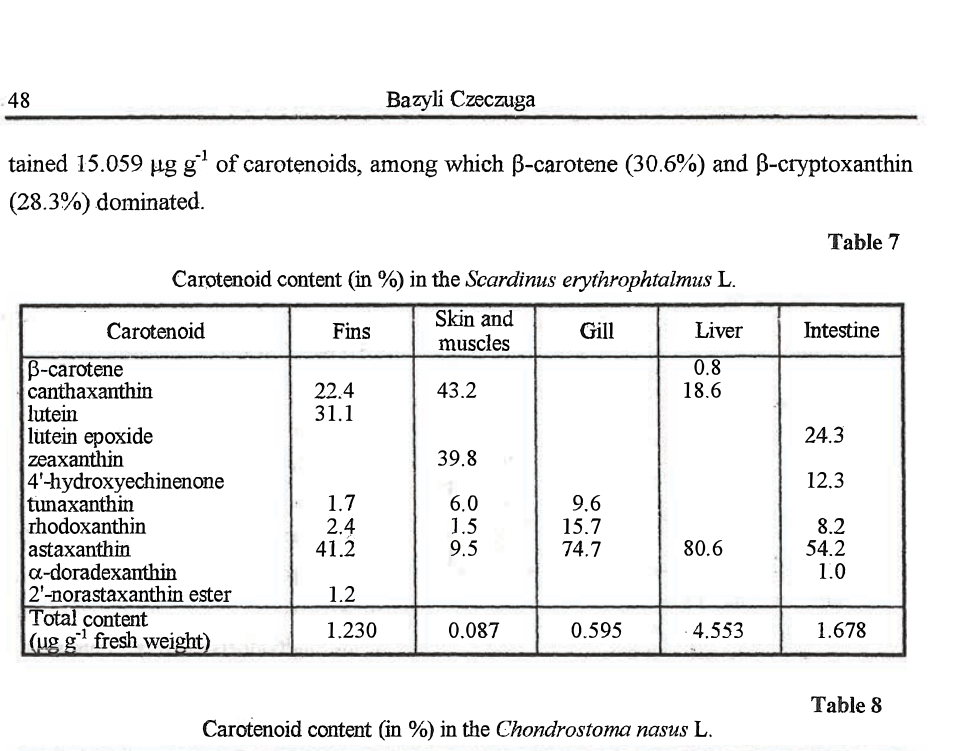
Carotenoid content (in %) in the Chondrostoma nasus